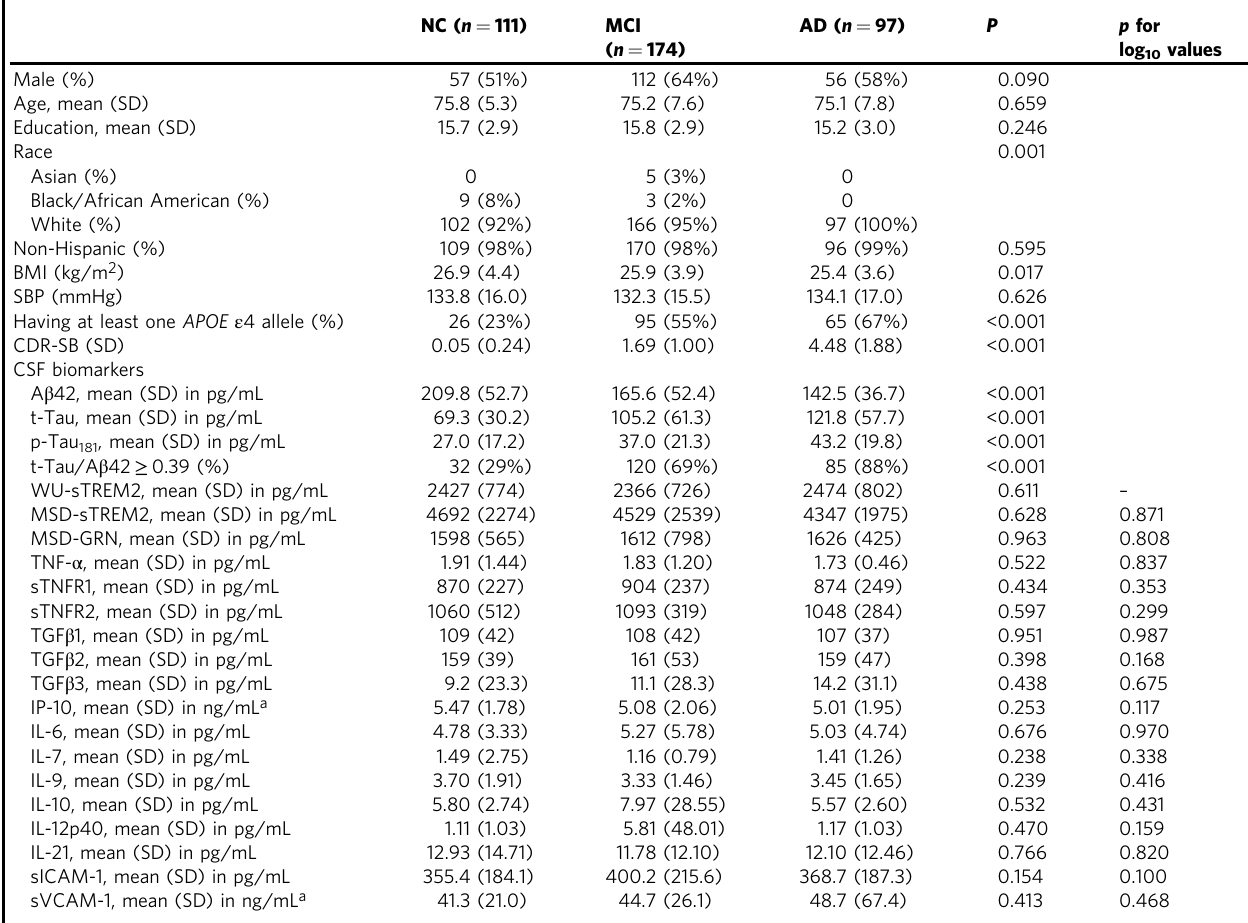
Table 1 Subjects included in study from ADNI, with p values shown for all continuous factors without log 10 transformation but also for CSF in fl ammatory proteins after log 10